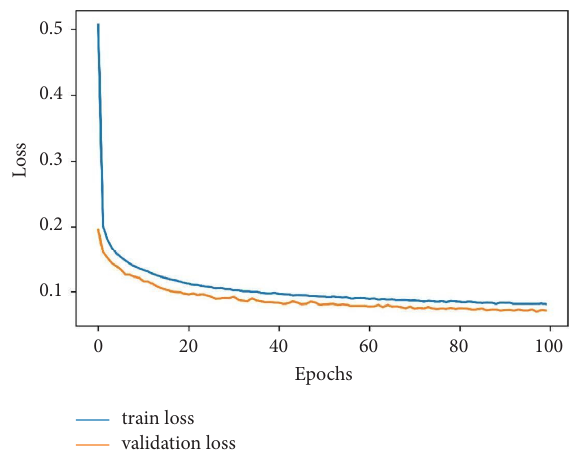
Figure 4: Overview of the deep neural network architecture presented. Te network inputs are E according to one or two objectives or specifed parameters for us.